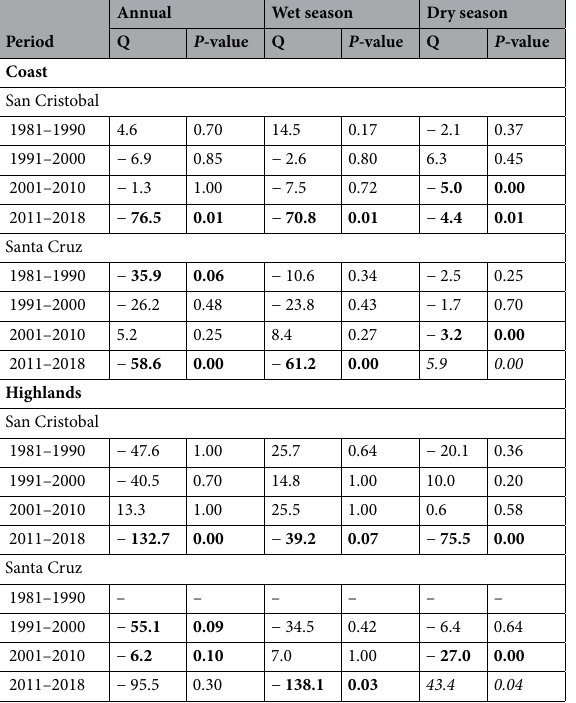
Table 1. Precipitation trend analysis for San Cristobal and Santa Cruz Islands for the 1981–2018 period. Trends were obtained from a Modified Mann–Kendall’s Test (MMKT) to investigate the presence of monotonic trends (upward or downward) 25 . Results of trend tests are reported at a 90% confidence interval. Marked cells correspond those where a significant trend was found. Bold mark periods where a drying trend is observed, whereas those italics where a wetting trend is